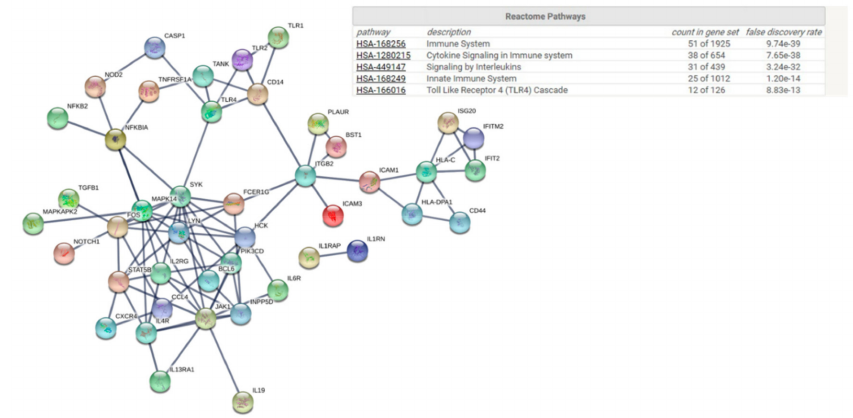
Figure 2. Protein–protein interaction (PPI) networks of immune DEGs between responders and non-responders in nasal lavage at baseline. Genes were clustered by